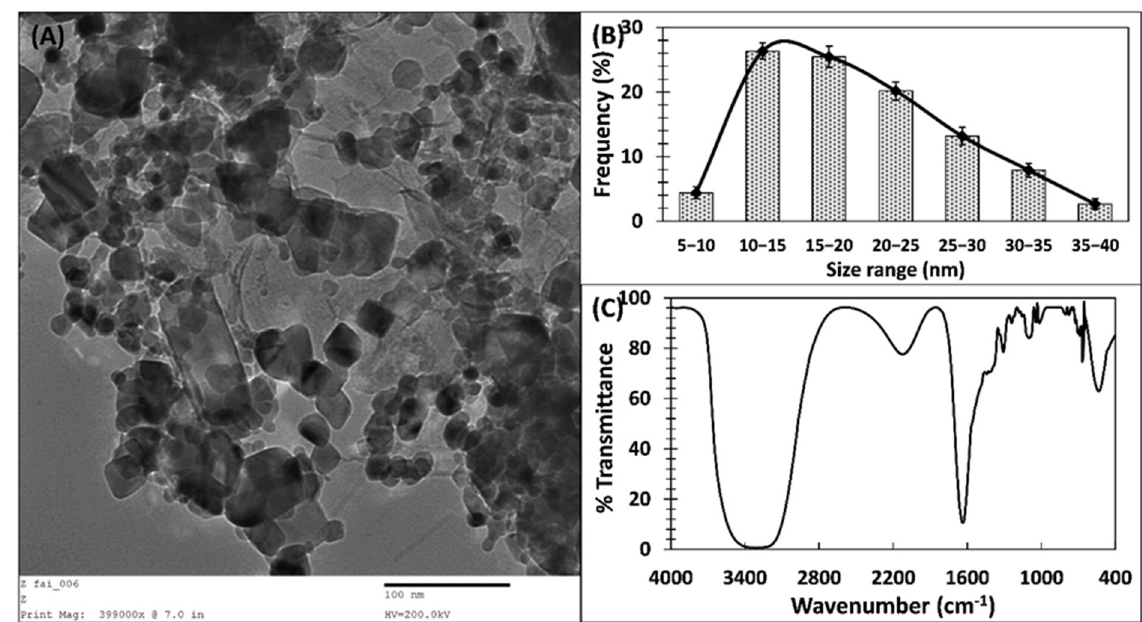
Figure 2. ( A ) Transmission electron micrograph of ZnO − NPs. ( B ) Particle size distribution histogram of ZnO − NPs. ( C ) Fourier-transform infrared spectrum of ZnO − NPs.